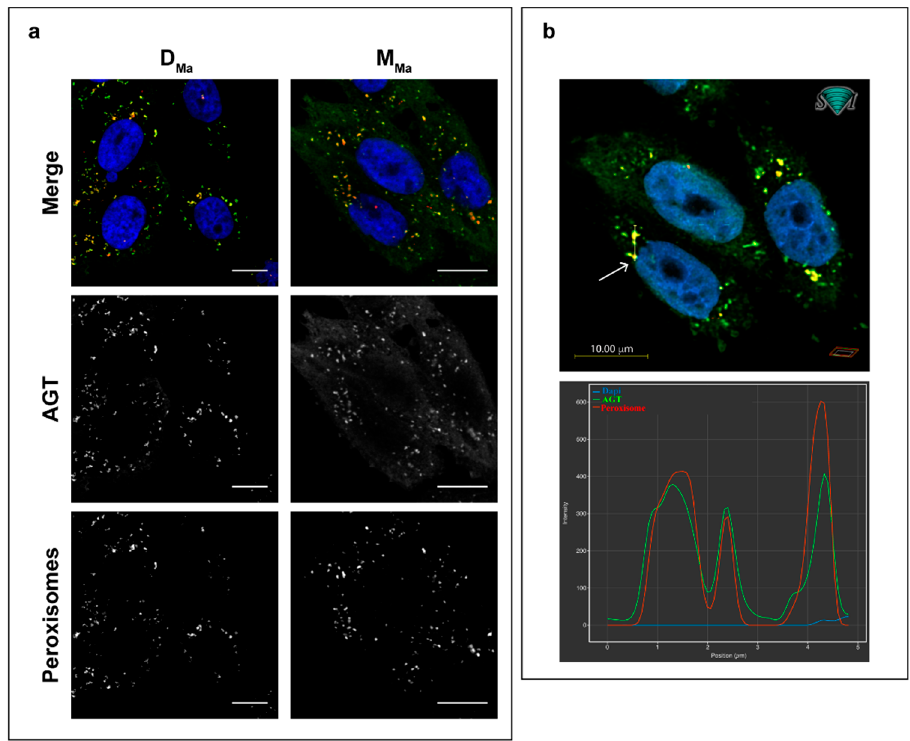
Figure 3. Subcellular distribution of monomeric and dimeric AGT. ( a ) CHO-GO cells expressing either D Ma or M Ma were fixed and stained with antibodies against AGT (green) and peroxisomal protein catalase (red). Nuclei were stained with Dapi (blue). Merged and single channel images come from a single z-plane. Scale bar: 10 µm. ( b ) Deconvolution of IFM images for M Ma shown in panel (a) along with the corresponding RGB profiles.